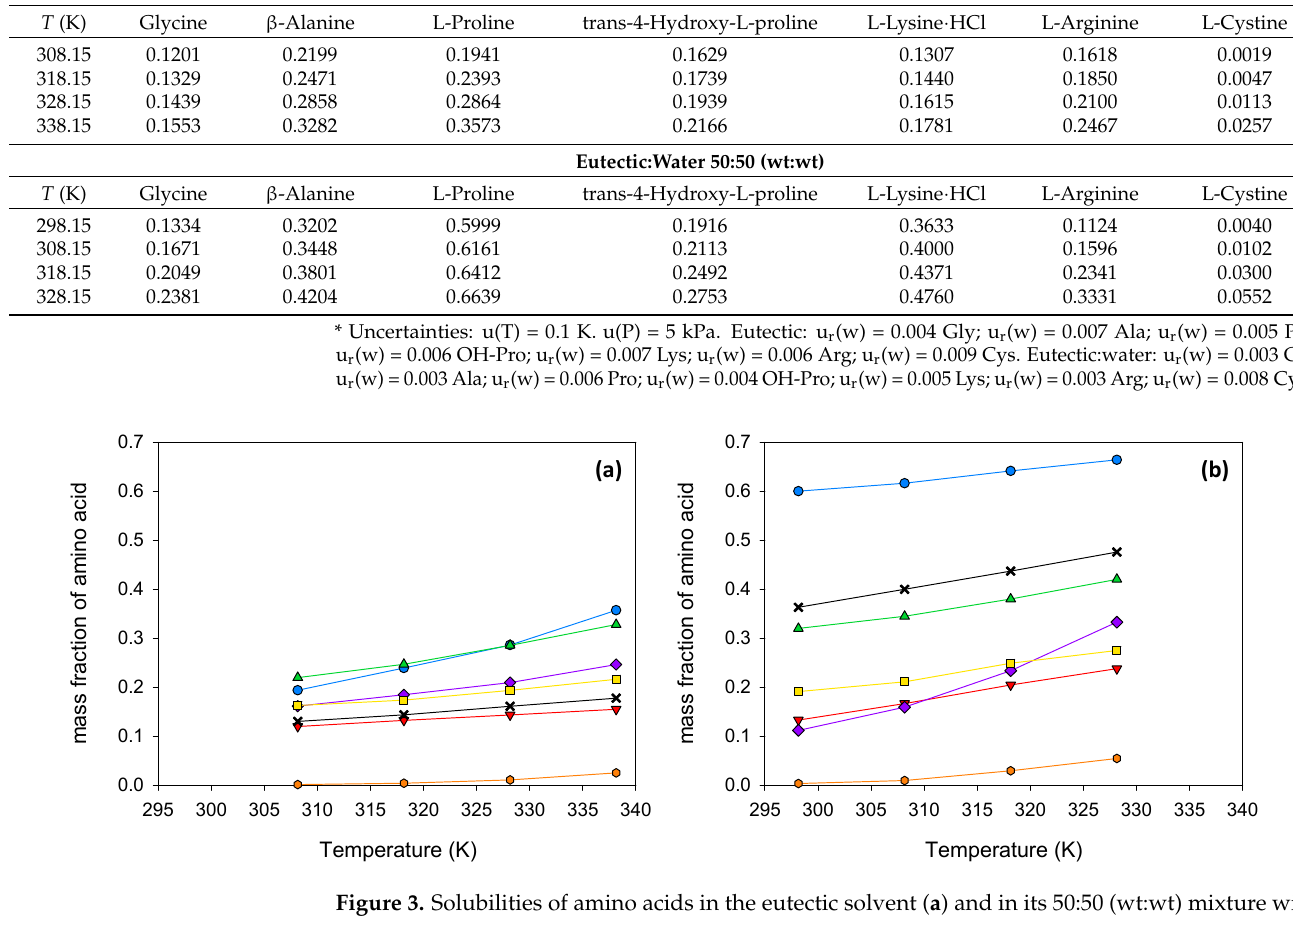
Table 3. Solubilities (mass fraction) of different amino acids in the eutectic solvent and in its mixtures with water, 50:50 (wt:wt), at different temperatures and 0.1 MPa *. Eutectic